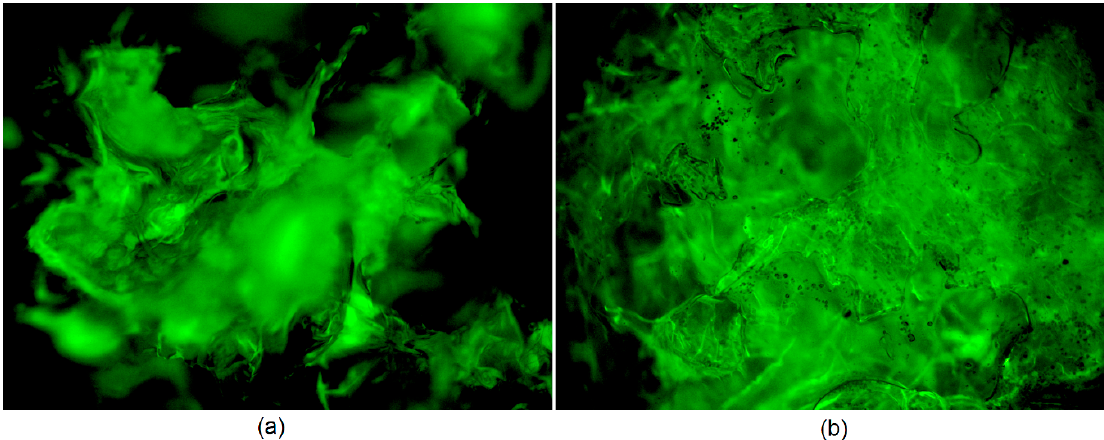
Figure 7. Microphotographs of the samples : ( a ) swollen hydrogel (40×); and ( b ) swollen hydrogel modified with ZnO nanoparticles and immobilized CBD (40×) .